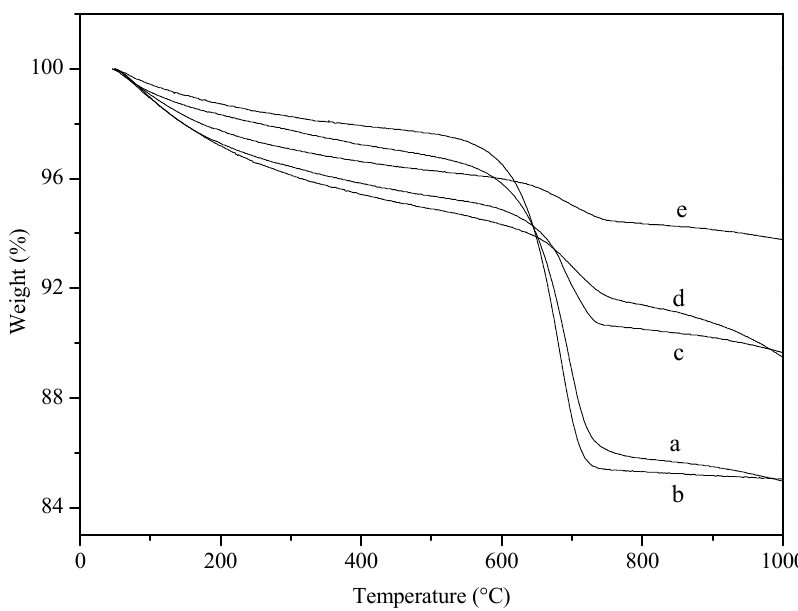
Figure 5. TG curves of the spent egg-shell catalysts collected after operation for 10